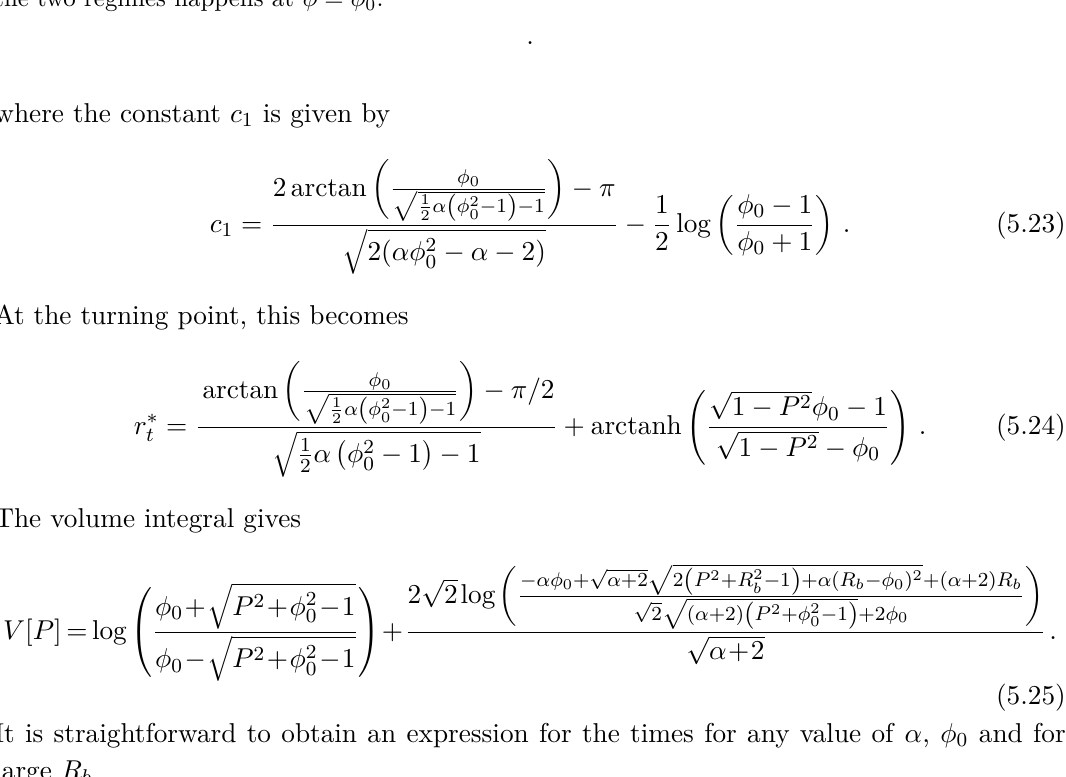
Figure 11. The AdS-to-AdS potential for α > 0 (left) and α < 0 (right). The crossing between the two regimes happens at φ = φ 0